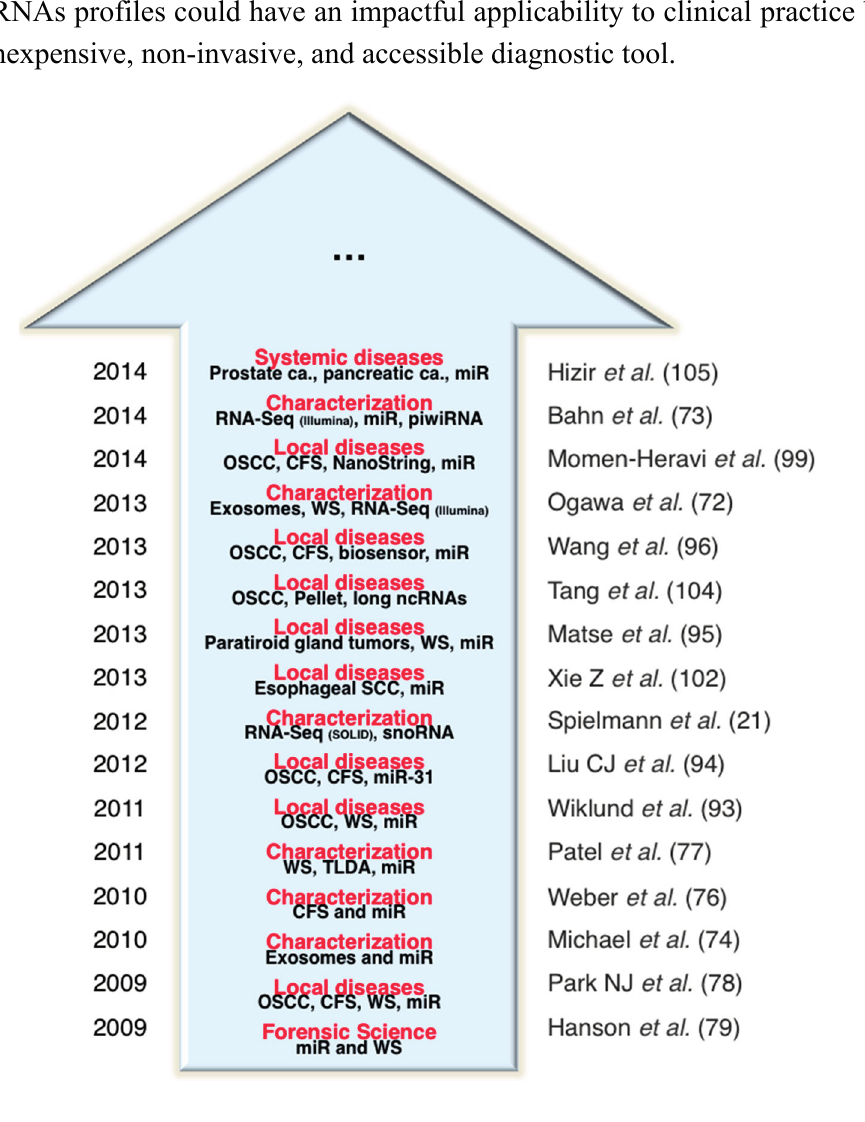
Figure 1. The rise of non-coding RNA in